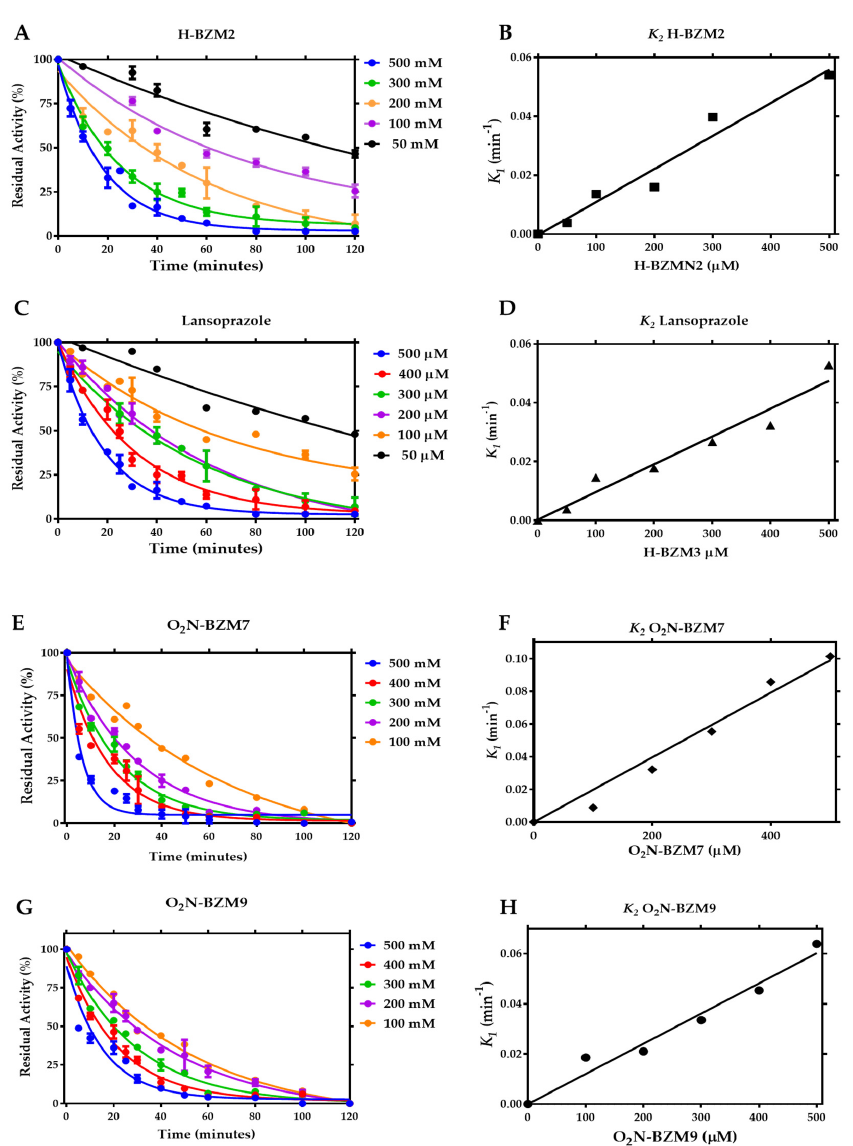
Figure 6. Inactivation assays of the TPI enzyme from G. lamblia with H-BZM2 , lansoprazole, O 2 N-BZM7 , and O 2 N-BZM9 . ( A , C , E , G ) The pseudo-first-order rate constant values ( k 1 ) for each compound were calculated by fitting the data to the exponential decay equation A = A 0 e- k1t , where A 0 is the initial activity value. All experiments were performed in triplicate; the bars represent the standard error. ( B , D , F , H ) The second-order rate constant values of inactivation ( k 2 ) were obtained by plotting the k 1 values against the concentrations of compounds and adjusted to a linear regression model. All the experiments were performed in triplicate; standard errors were lower than 5%.